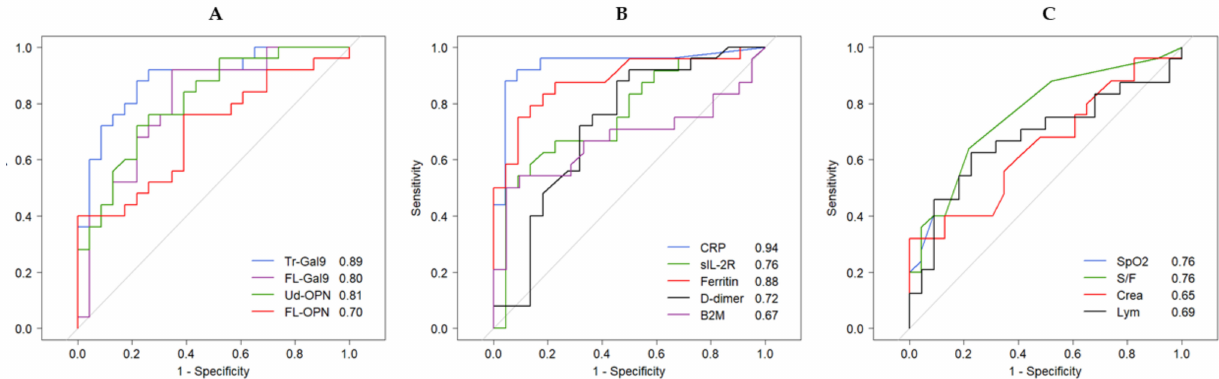
Figure 5. ROC analysis of inflammatory, coagulation, kidney and respiratory indicators between the CV and CP groups. Gal-9 and OPN ( A ), inflammatory markers ( B ), and respiratory, kidney and hematological markers ( C